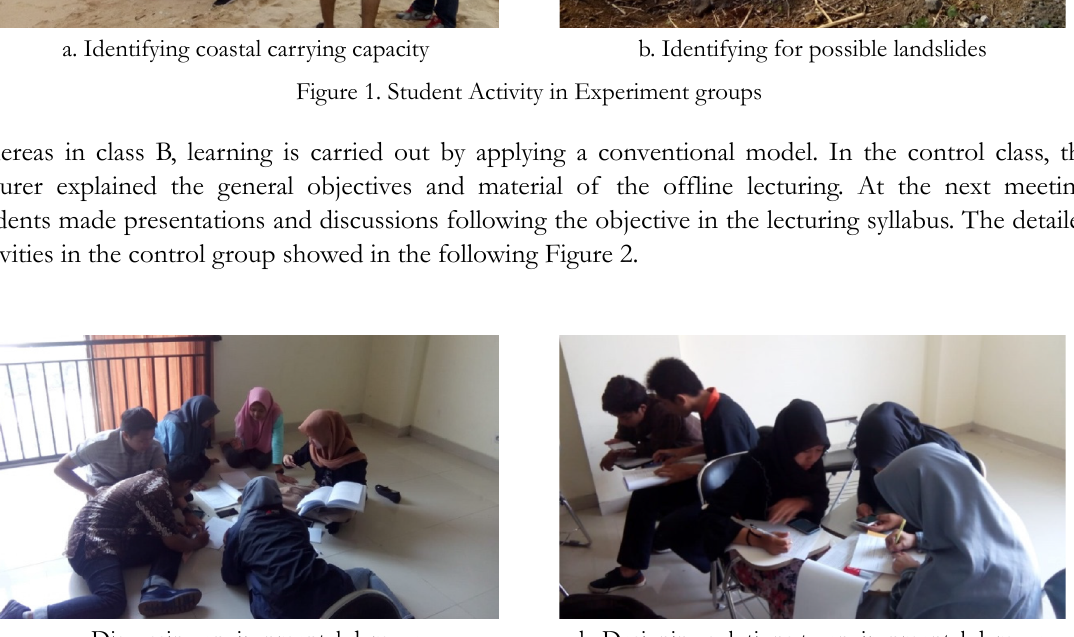
Figure 2. Student Activities in Control groups